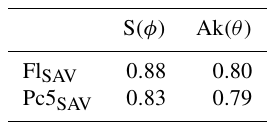
Table 4. Correlation coefficients between functional dependencies of the angles (S (φ) and Ak (θ) ; see text for details) and observational curves (Pc5 SAV and FL SAV ).